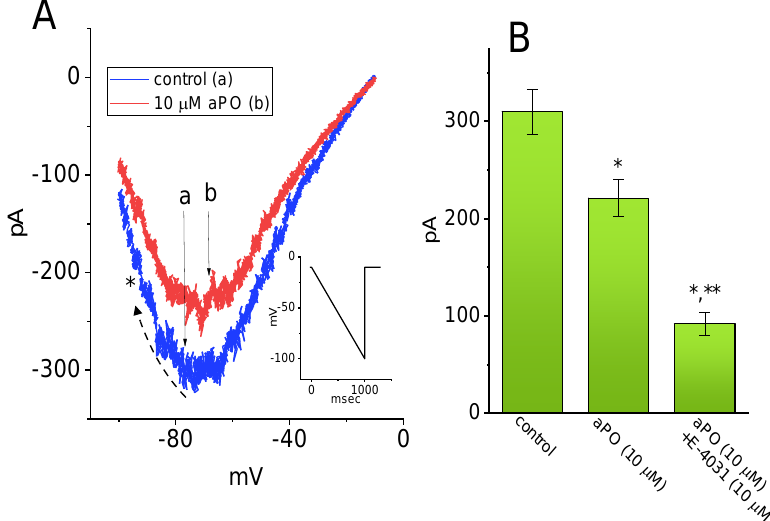
Figure 7. Effect of aPO on erg-mediated K+ current (I K(erg) ) in GH 3 cells. The experiments were un- dertaken in cells that were bathed in high-K + , Ca 2+ -free solution containing 1 μM tetrodotoxin (TTX), and the recording pipette was filled up with K + -containing internal solution. ( A ) Representative I K(erg) traces obtained in the control (a) and during cell exposure to 10 μM aPO (b). The examined cell was held at −10 mV and a downsloping ramp from −10 to −100 mV with a duration of 1 s (indicated in the inset) was applied to it. The dashed arrow indicates the direction of current trajectory in which time passes, while the asterisk shows the inwardly-rectifying property of I K(erg) . ( B ) Summary bar graph showing effect of aPO and aPO plus E-4031 on the amplitude of I K(erg) (mean ± SEM; n = 8 for each bar). Current amplitude (i.e., peak I K(erg) amplitude) was measured at the level of −70 mV. Data analyses were performed by ANOVA-1 ( p < 0.05). * Significantly different from control ( p < 0.05) and ** significantly different from the aPO (10 μM) alone group ( p < 0.05).